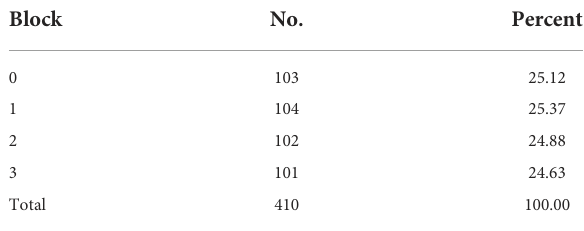
TABLE 3 The distribution of the survey sample by